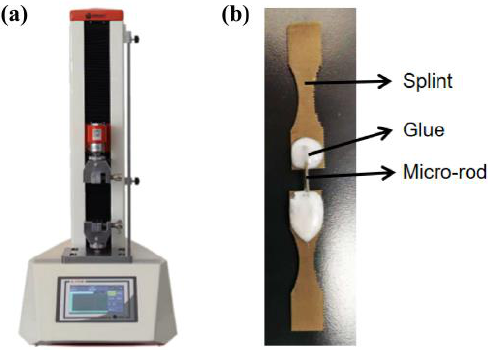
Figure 2. Desktop universal testing machine and micro-rod stress – strain testing parts display: ( a ) testing machine, ( b ) testing parts.